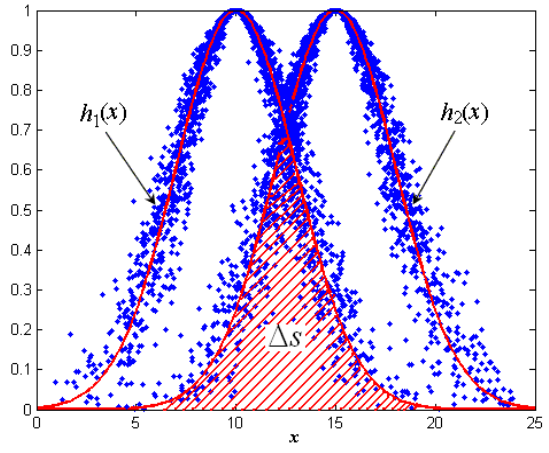
Figure 3. The similarity of two normal cloud models.